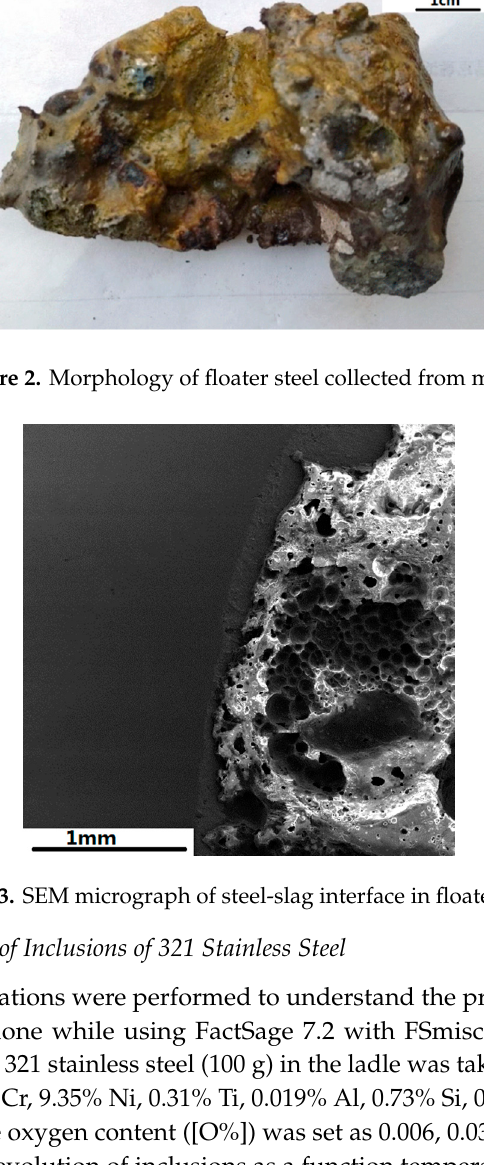
Table 1. Main composition (wt. %) and Physical properties of the samples collected from mold.